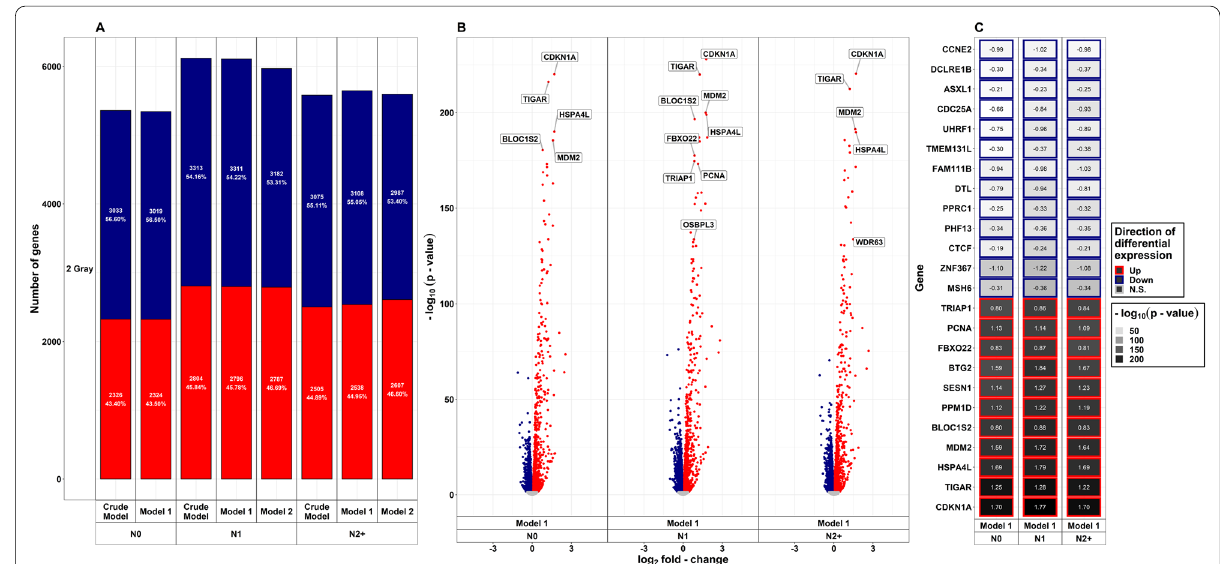
Fig. 5 Summarized results on differential gene expression after 2 Gray . Differentially expressed genes in irradiated compared to sham‑irradiated fibroblasts from donors with a first primary neoplasm only (N1), donors with at least one second primary neoplasm (N2 cancer‑free controls (N0) 4 h after exposure to 2 Gray (false discovery rate adjusted p ‑value < 0.05). The data are presented for the crude model, model 1 (considering age at sampling and sex), and model 2 [considering age at sampling, sex, age at and year of diagnosis of the first neoplasm, and tumor type (not applicable for N0 data)]. In total, 14,756 genes were detected in the samples. Shown are A the proportion of up‑ and downregulated genes stratified by dose, group, and model, B volcano plots for the results of model 1, and C top 10 genes with regard to p ‑value, stratified by direction of log 2